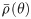
Simulations of (2) with synaptic coupling.Panels B and C show traces for 30 representative neurons from a synaptically coupled network without and with 180 Hz DBS pulsing, respectively. In Panel A, snapshots of the probability density are taken at 90 Hz. At t = 0.5 seconds, pulsatile stimulation is turned on. Panel D shows characteristic synaptic currents felt by a single neuron with and without DBS pulsing. Panel F shows the probability density ρ¯(θ) averaged over multiple snapshots after initial transients have decayed when DBS pulsing is on and panel E gives the cumulative distribution. Here, we observe a similar clustering pattern, with nearly equal amounts of neurons in each cluster.